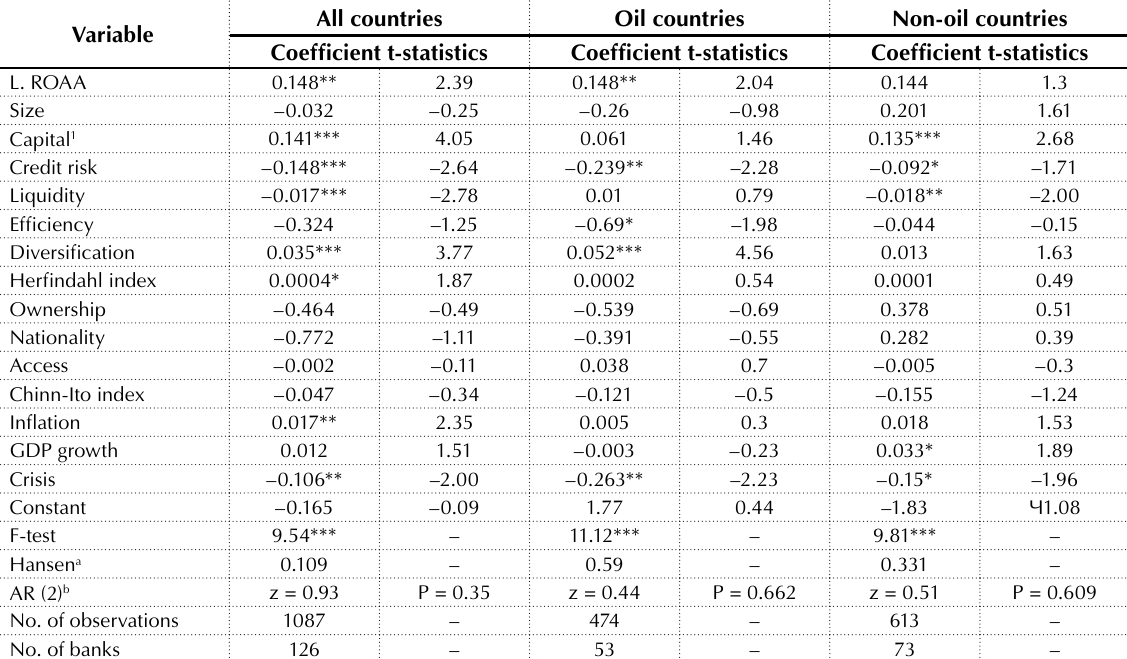
Table 3. GMM estimation results with ROAA as independent variable (total banks sample)